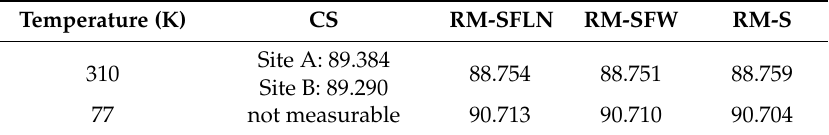
Table 1. Transition frequencies of the transition 7 / 2 → 5 / 2.